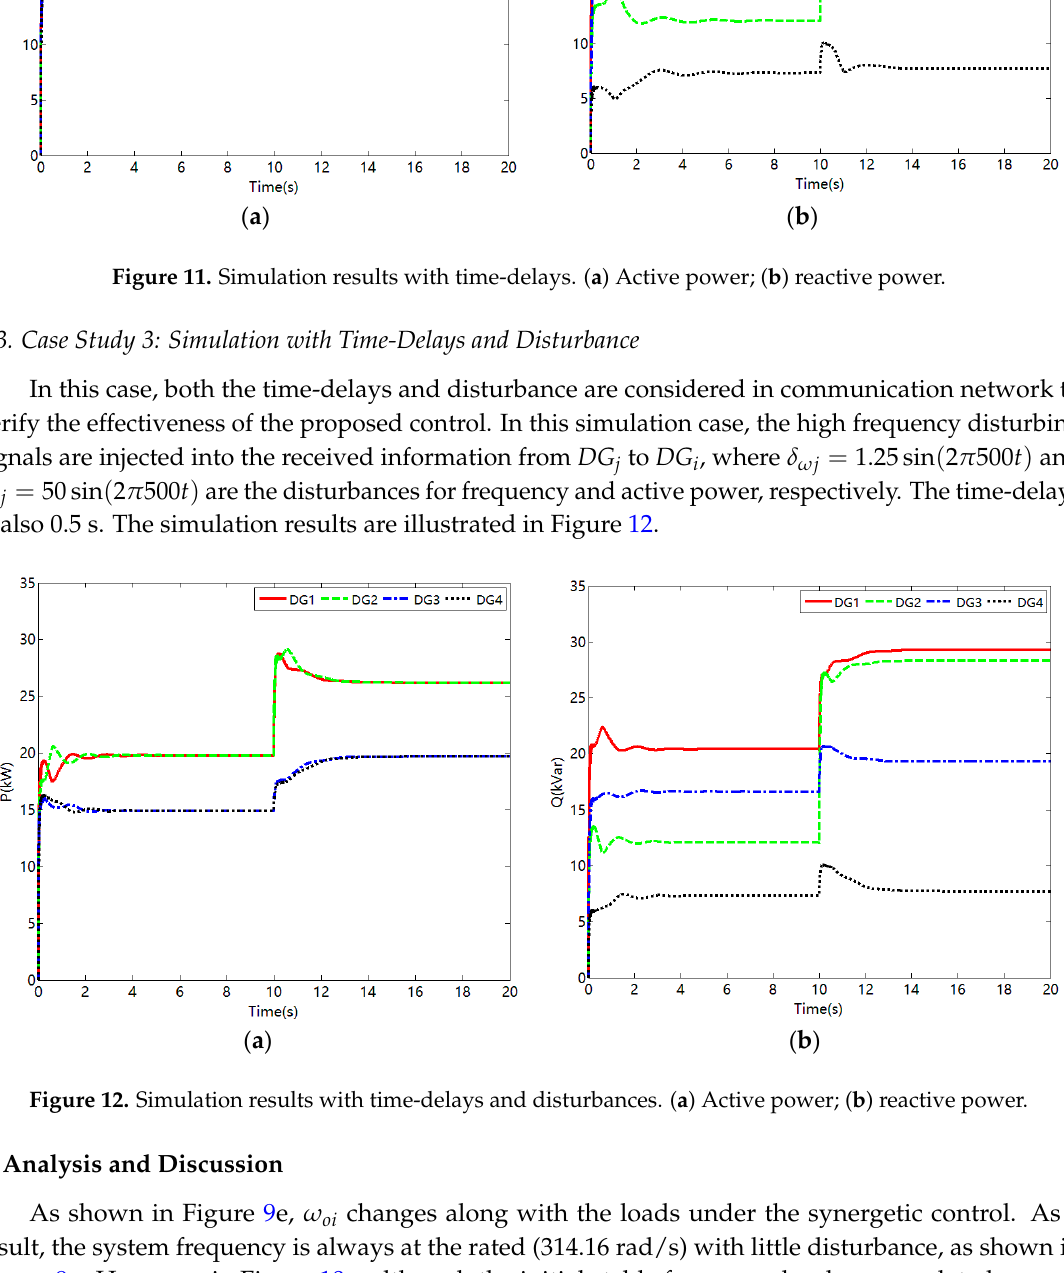
( d ) Figure 10. Simulation results with the traditional droop control. ( a ) Frequency; ( b ) active power of each DG; ( c ) voltage; ( d ) reactive power of each DG.